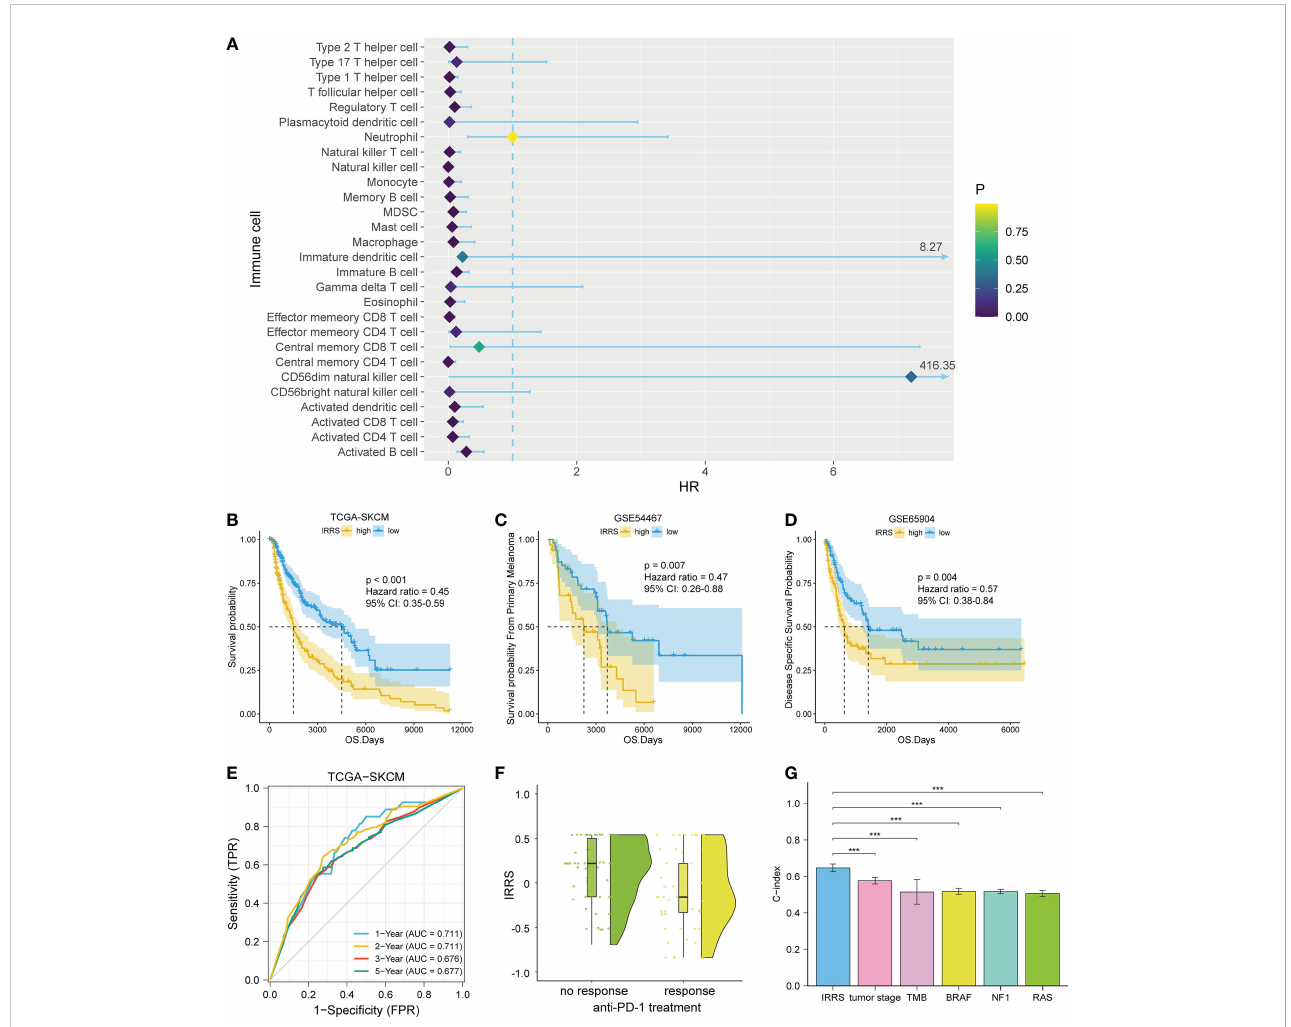
FIGURE 2 Construction and validation of the IRRS. (A) The 19 candidate cells screened based on uni-Cox analysis. (B – D) The Kaplan – Meier curves of survival probability for patients in the TCGA-SKCM, GSE54467, and GSE65904 cohorts. (E) The ROC curve for patients in the TCGA-SKCM cohort. (F) Comparison of immunotherapeutic responses ( P < 0.01) for patients in the GSE91061, GSE115821, and Liu et al. cohorts. (G) Comparison of C-index between the IRRS and tumor stage, TMB, and driver mutations (BRAF, NF1, and RAS) in the